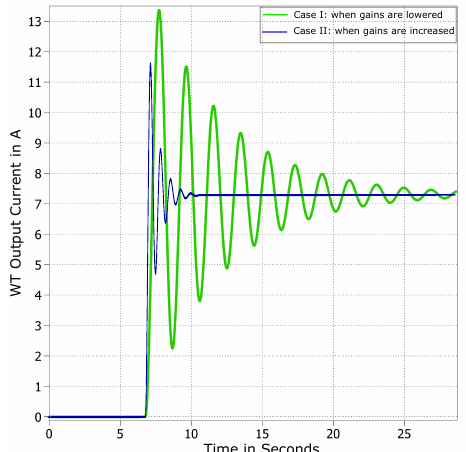
Figure 23. Simulink Verification—Effect of Variation of DC-DC Converter Gains on WT Output Cur-